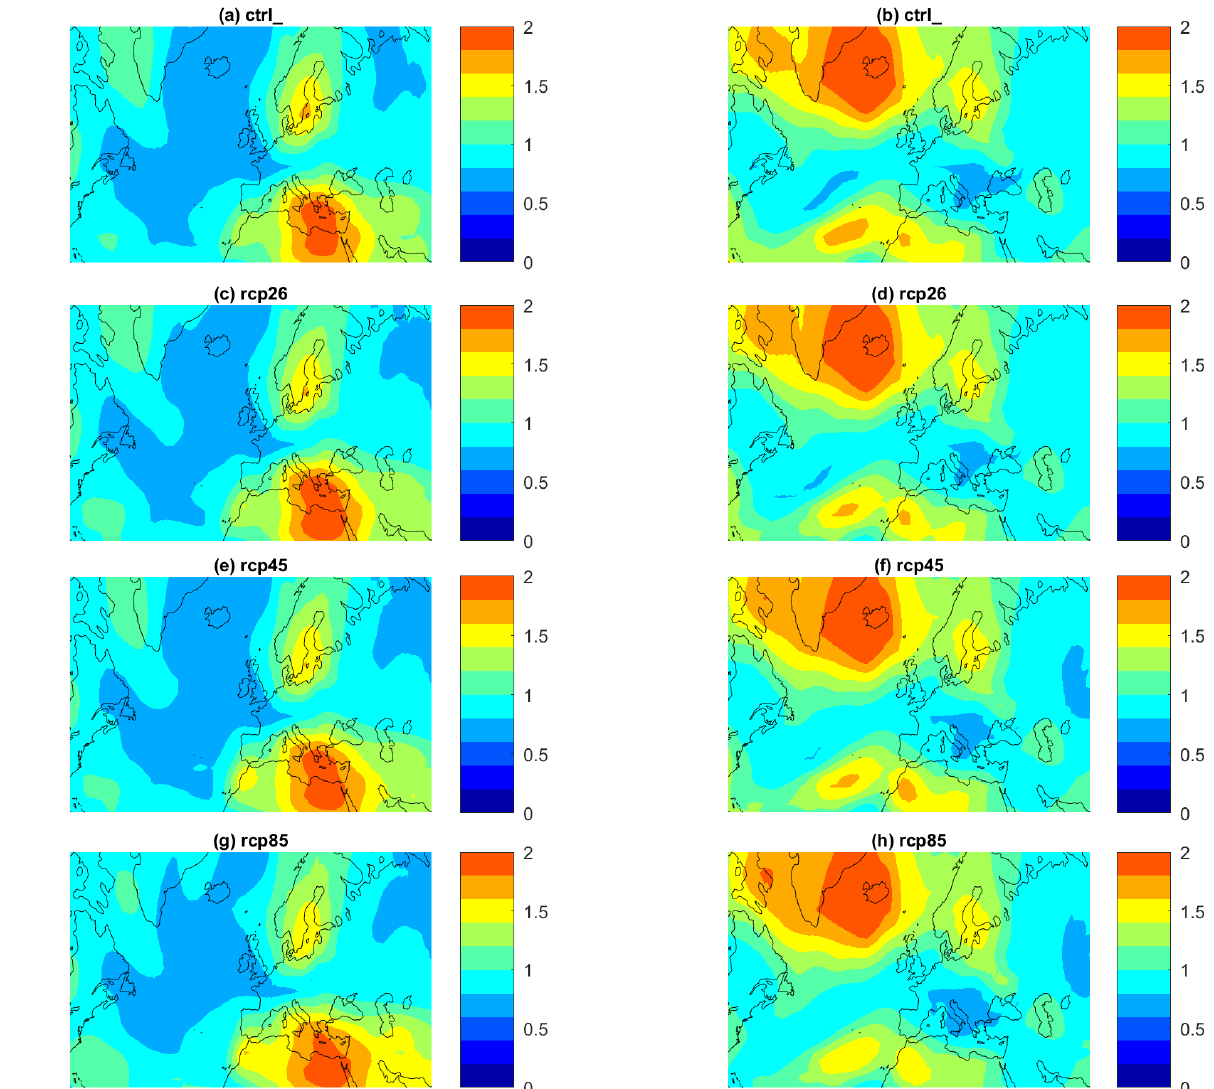
Figure B2. Sea-level pressure uncertainty in PlaSim analogues: root mean squared difference in standardized sea-level pressure (standard deviations) between analogues and cluster centroids for cluster 1 (a, c, e, g) and cluster 2 (b, d, f, h) . (a, b) Control run. (c, d) RCP2.6 run. (e, f) RCP4.5 run. (g, h) RCP8.5